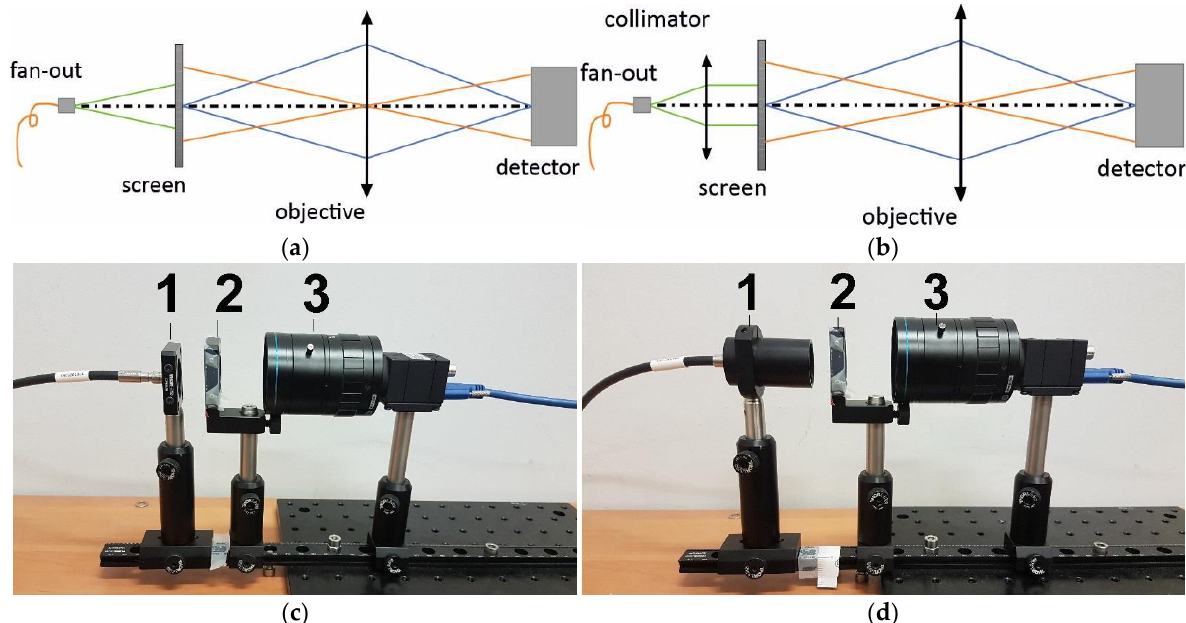
Figure 5. Schemes and images of a laboratory setup build for the performance of the measuring head tests ( a , c ) without the collimator and ( b , d ) with the collimator.